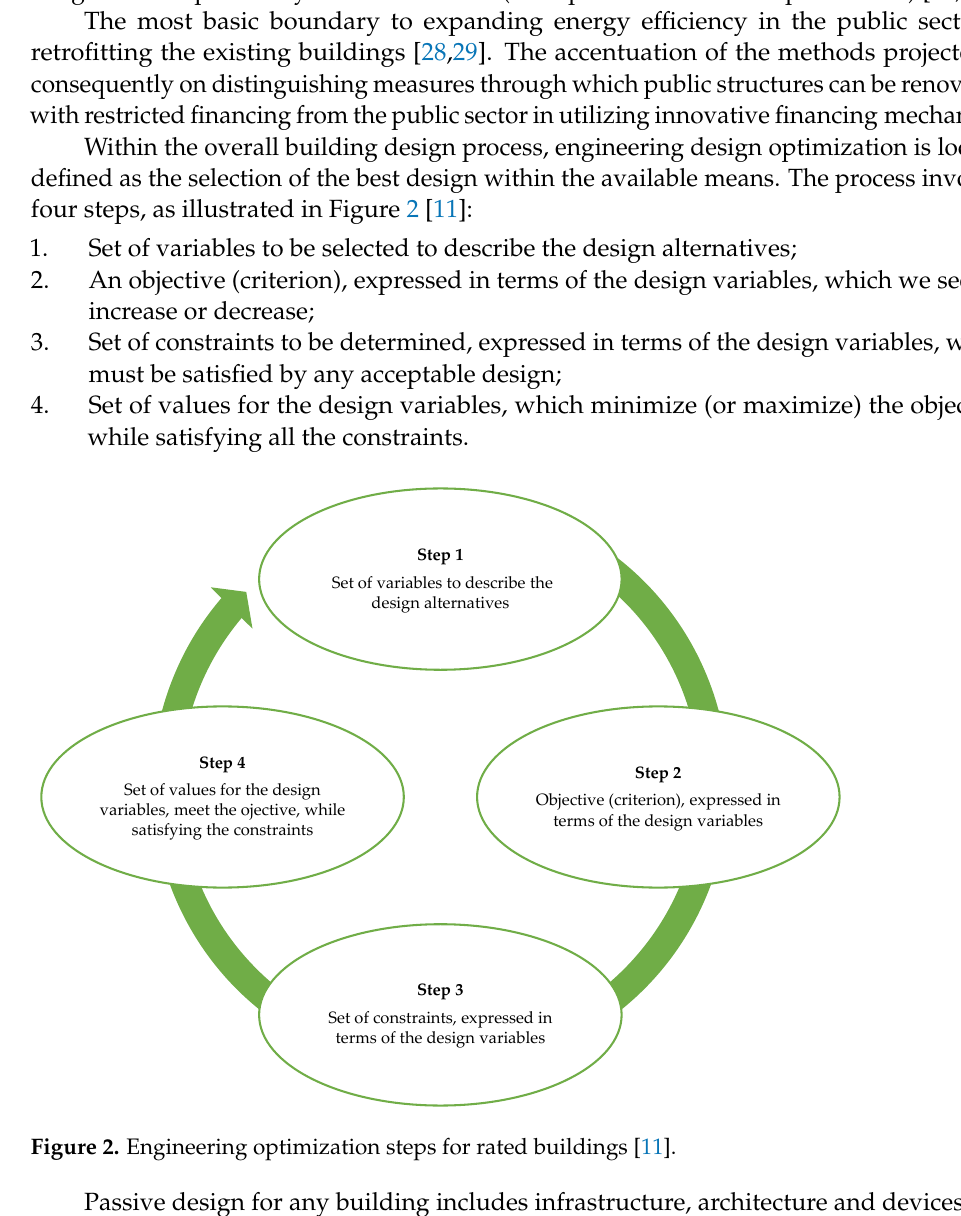
Figure 1. Flow chart of overall design building process [2].